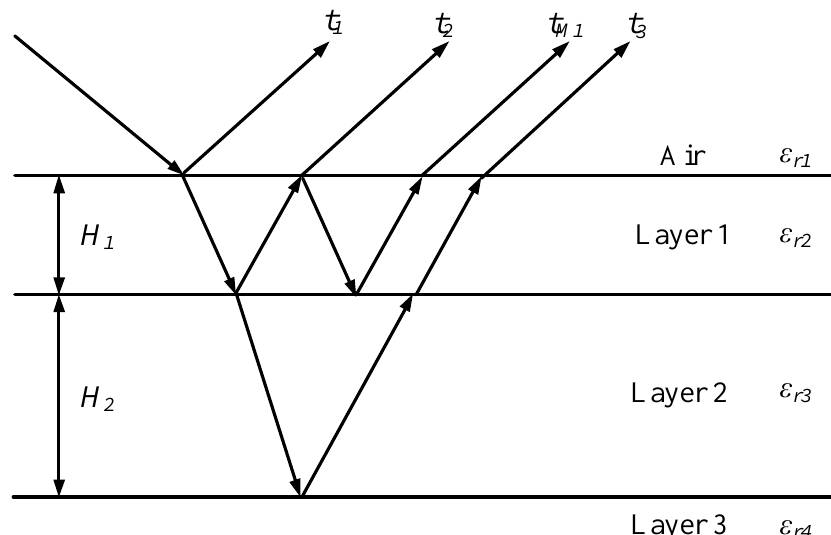
Figure 1. Pavement configuration; t k represents the time delay of the k -th interface, and t M 1 represents the time delay of a multiple